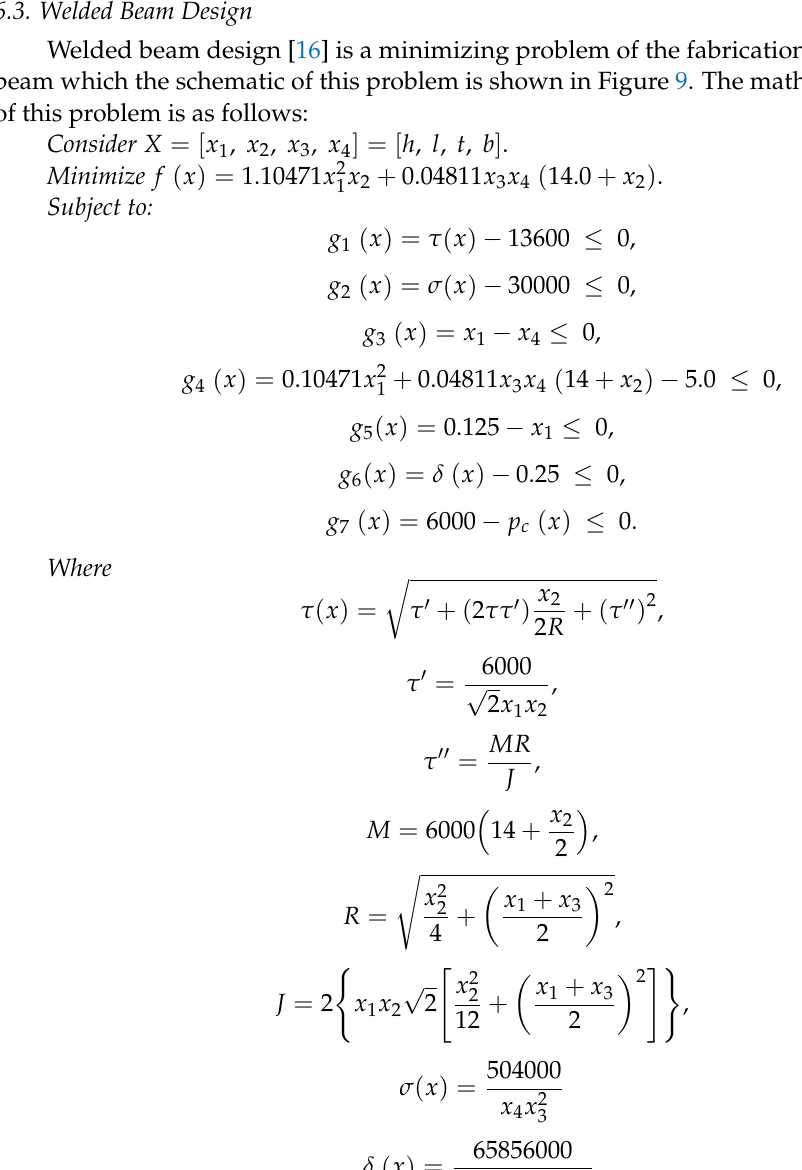
Figure 8. POA’s performance convergence curve on speed reducer design.